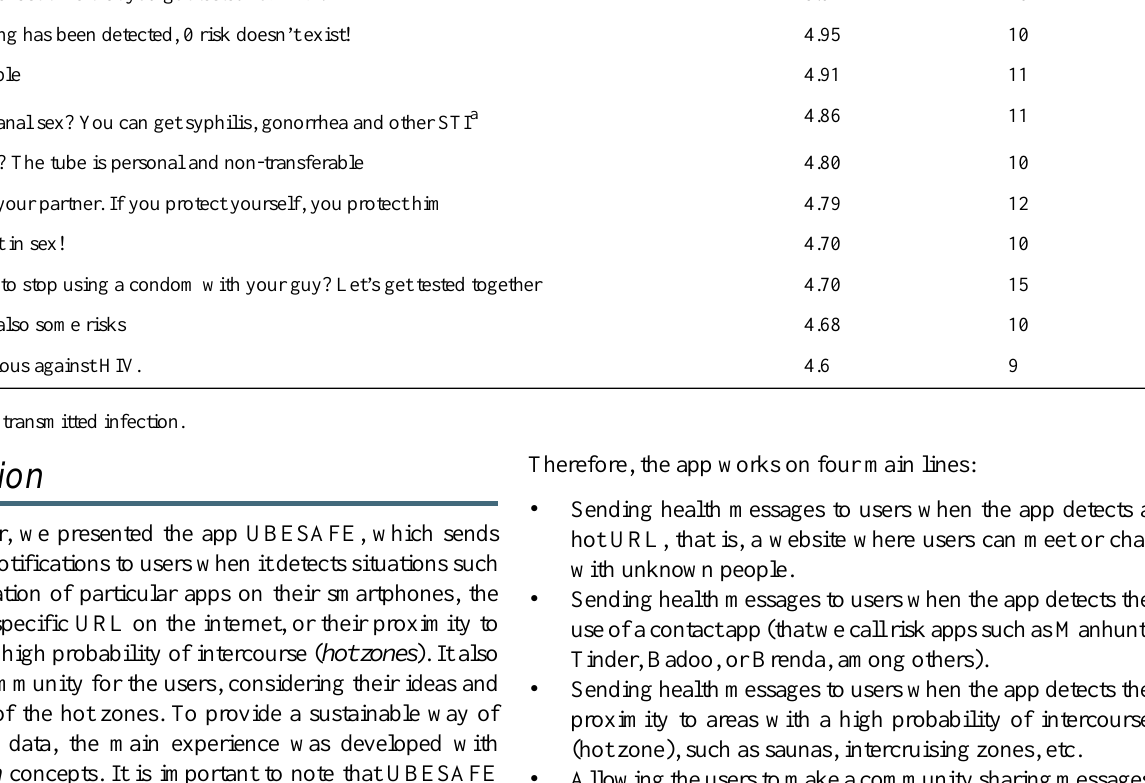
FrequencyAverage